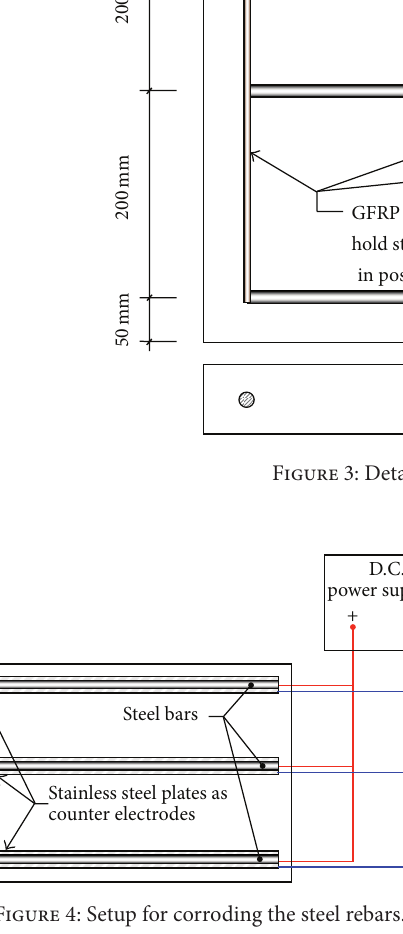
Table 2. Using the calculated values of polarization resistance, Stern-Geary constant, and surface area of the steel rebar (158.33 cm 2 ), the corrosion current density can be calculated = 46.57 × 10 3 /(6473 × 158.33) = using (3), as follows: 𝐼 corr 0.045 𝜇 A / cm 2 (without 𝐼𝑅 drop compensation) and 𝐼 corr